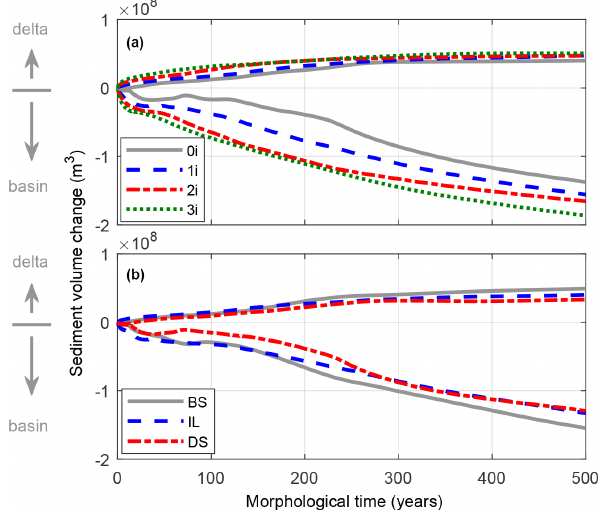
Figure 14. Cumulative sediment volume change over time of dif- ferent scenarios: (a) scenarios of the different mouth island numbers and (b) scenarios of different mouth island